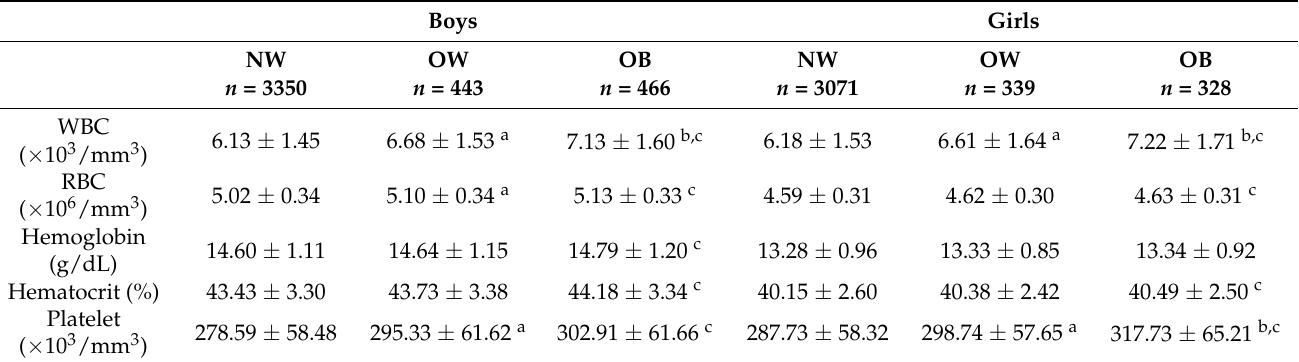
Table 2. Mean white blood cell (WBC), red blood cell (RBC), hemoglobin, hematocrit, and platelet levels according to sex and obesity.